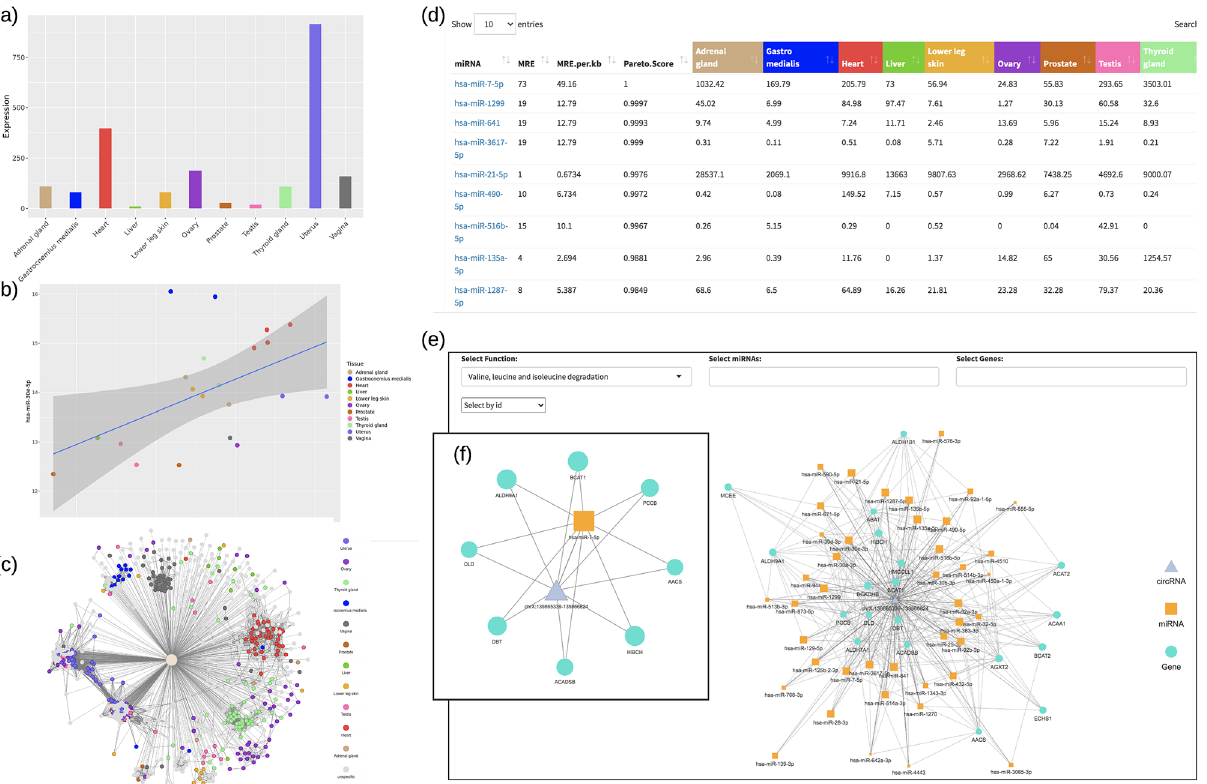
Figure 4. Web interface of Cerina. ( a , b ) In the data exploration section, users can query an mRNA, miRNA, or circRNA to examine its expression across different tissues. Users can also perform correlation analysis for ceRNA interactions. ( c ) MiRNA-circRNA interaction page allows users to visualize and report tissue- specific miRNA-circRNA interactions as a network. ( d ) CircRNA-miRNA exploration tab reports all miRNAs interacting with a selected circRNA as a downloadable table displaying MRE, Pareto score, and miRNA expression. ( e ) Functional analysis tab reports significantly enriched pathways and gene ontology terms that can be visualized as a network displaying the selected circRNA with interacting miRNAs and genes. ( f ) Users can choose a subset of miRNAs/genes/functions to display in the network. R packages ggplot2 v3.3.2 (https :// cran.r-proje ct.org/web/packa ges/ggplo t2/index .html), visNetwork v2.0.9 (https ://cran.r-proje ct.org/web/packa ges/visNe twork /index .html), and DT v0.15 (https ://cran.r-proje ct.org/web/packa ges/DT/index .html), were used to create the